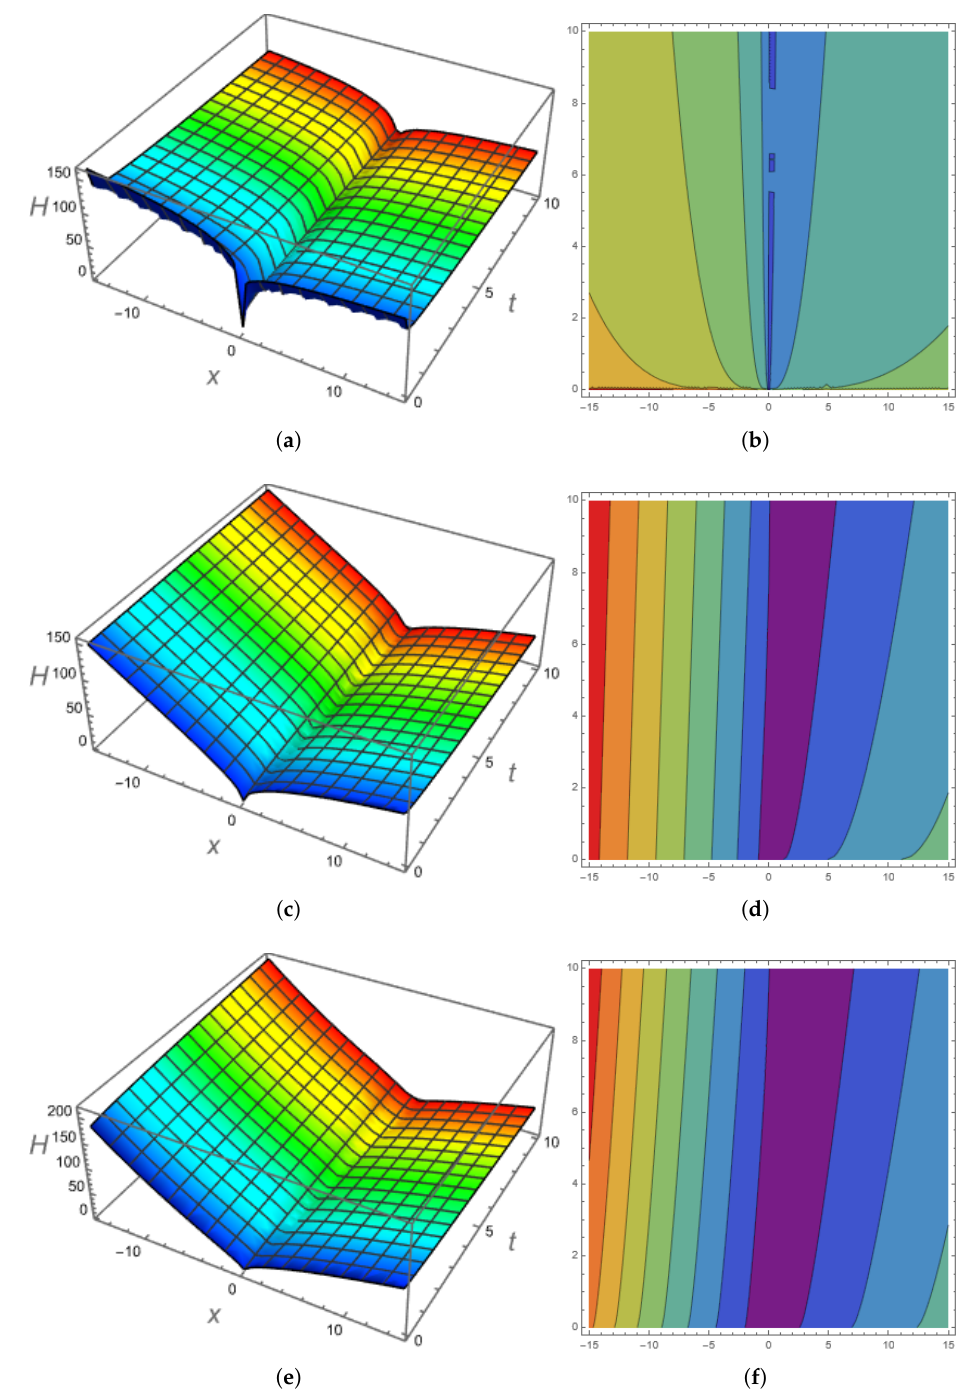
Figure 2. Rational function solution of H 34 ( x , t ) for the values of α = − 1, κ = 0.1, µ = 0.9, δ = 0.01, γ = − 2. ( a ) 3-D wave profile at fractional order ζ = 0.1. ( b ) Contour wave profile at fractional order ζ = 0.1. ( c ) 3-D wave profile at fractional order ζ = 0.5. ( d ) Contour wave profile at fractional order ζ = 0.5. ( e ) 3-D wave profile at fractional order ζ = 0.7. ( f ) Contour wave profile at fractional order ζ =